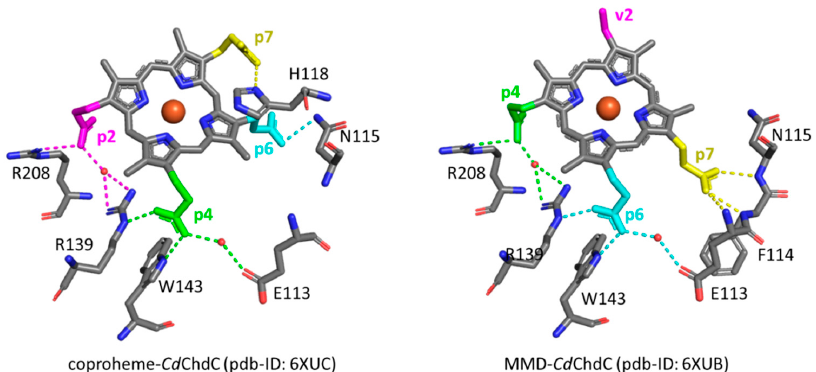
Figure 9. Hydrogen bonding interactions (dotted lines) of propionate groups in coproheme and 90 ◦ rotated MMD Cd ChdC complexes. Dotted lines of the p2 H-bonding interactions are depicted in magenta, p4 in green, p6 in cyan, and p7 in yellow, respectively. All other carbon atoms are represented in grey, oxygen atoms in red, nitrogen atoms in blue and the heme iron in orange [13]. Red circles indicate water